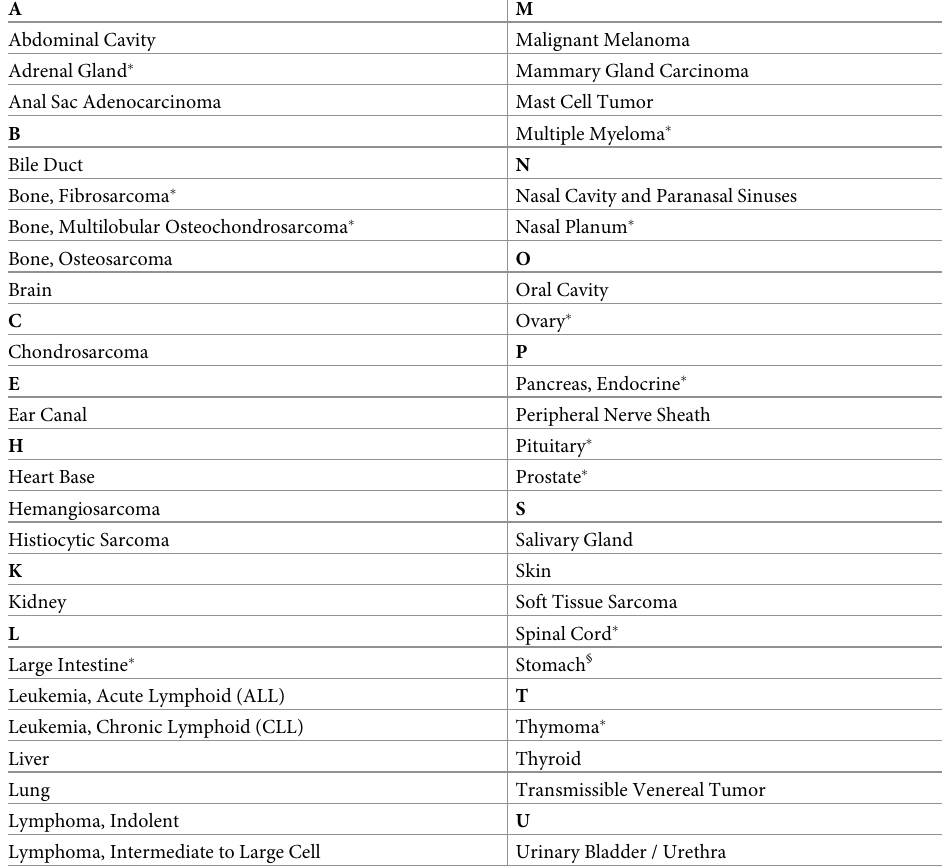
Table 4. List of all cancer types represented in cancer-diagnosed subjects from the training and testing sets of the CANDiD study. A M Abdominal Cavity Malignant Melanoma Adrenal Gland � Mammary Gland Carcinoma Anal Sac Adenocarcinoma Mast Cell Tumor B Bile Duct Bone, Fibrosarcoma � Bone, Multilobular Osteochondrosarcoma � Bone, Osteosarcoma